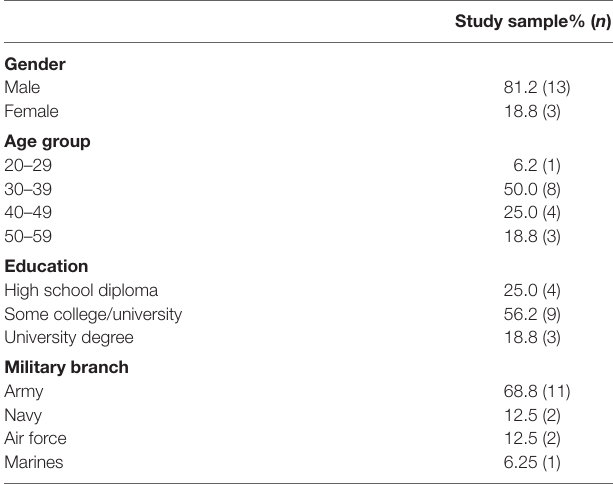
Table 3 | list of sociodemographic factors of study